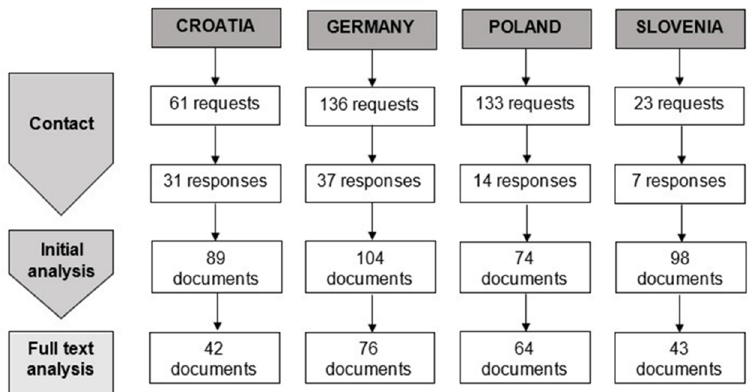
Figure 1. Procedure of the